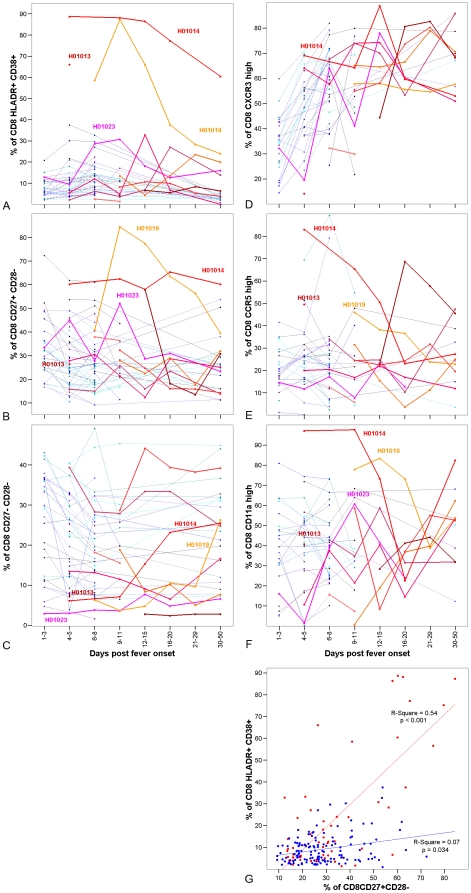
Activation and differentiation marker expression by CD8 T cells from patients with severe versus mild influenza.Panels a–f show the percentages of cells expressing the markers indicated on the vertical axis by time interval since onset. Each line represents an individual patient. Panel g shows the relationship between the percentages of CD8 T cells that are CD38+HLADR+ and CD27+CD28− and includes results for all time points. Results are shown for 10 patients with severe influenza (red tones symbols and lines) and 39 patients with mild influenza (blue tone symbols and lines).